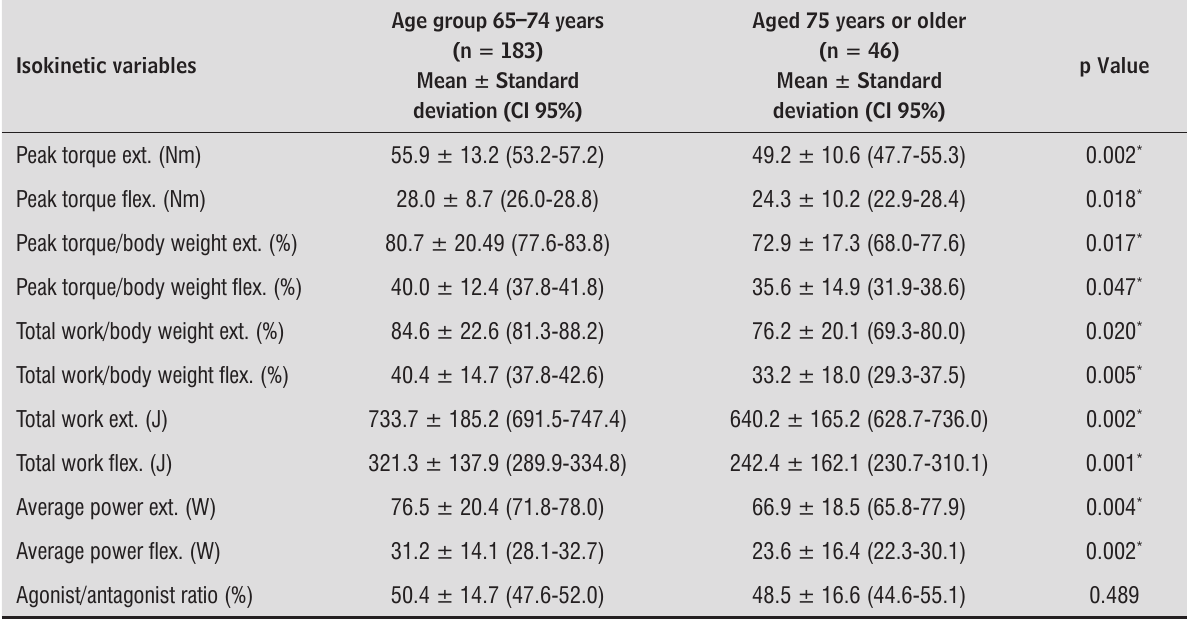
Table 3 - Values of the isokinetic variables for the extensors and flexors of the knee angular velocity of 180 °/s according to age group (n =